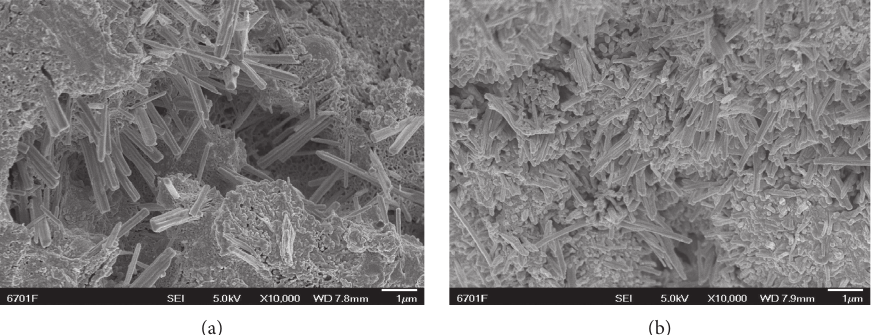
Figure 5: SEM diagram of different positions of concrete. (a) The exposed end. (b) The embedded